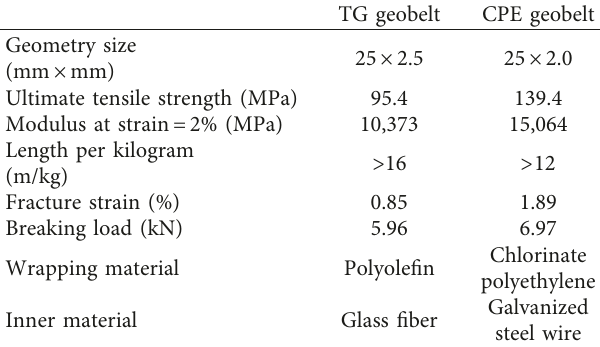
Figure 4: Photo of geobelts: (a) TG geobelt; (b) CPE geobelt. Table 3: Engineering properties of the geobelts.